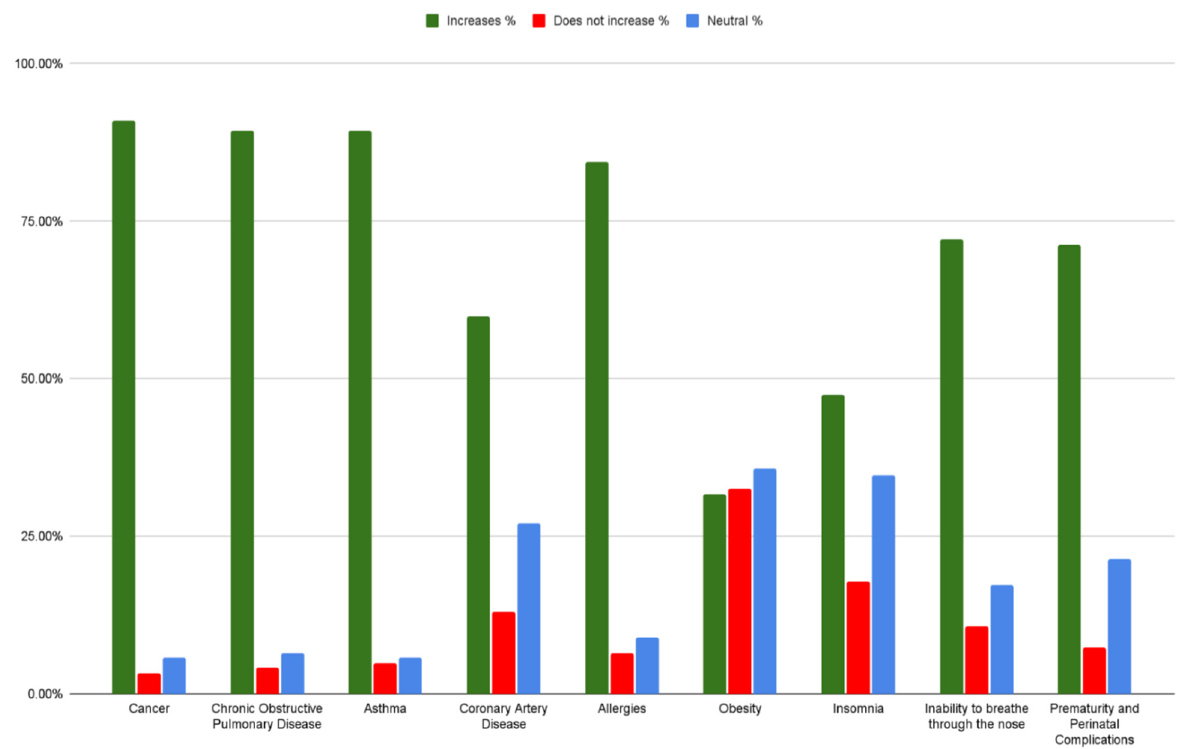
Figure 3. Answers to the question “To what extent do you think air pollution increases the risk of the following health conditions?”